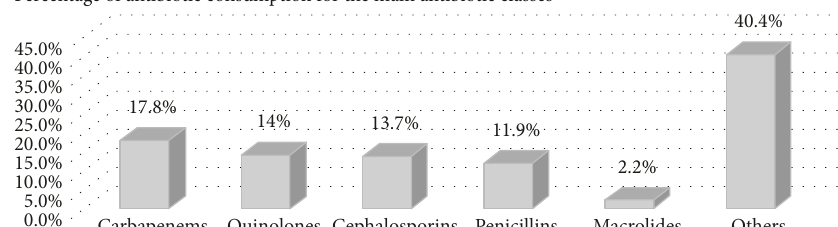
Figure 2: Distribution of total antibiotic consumption in Polish ICUs by main antibiotic classes.